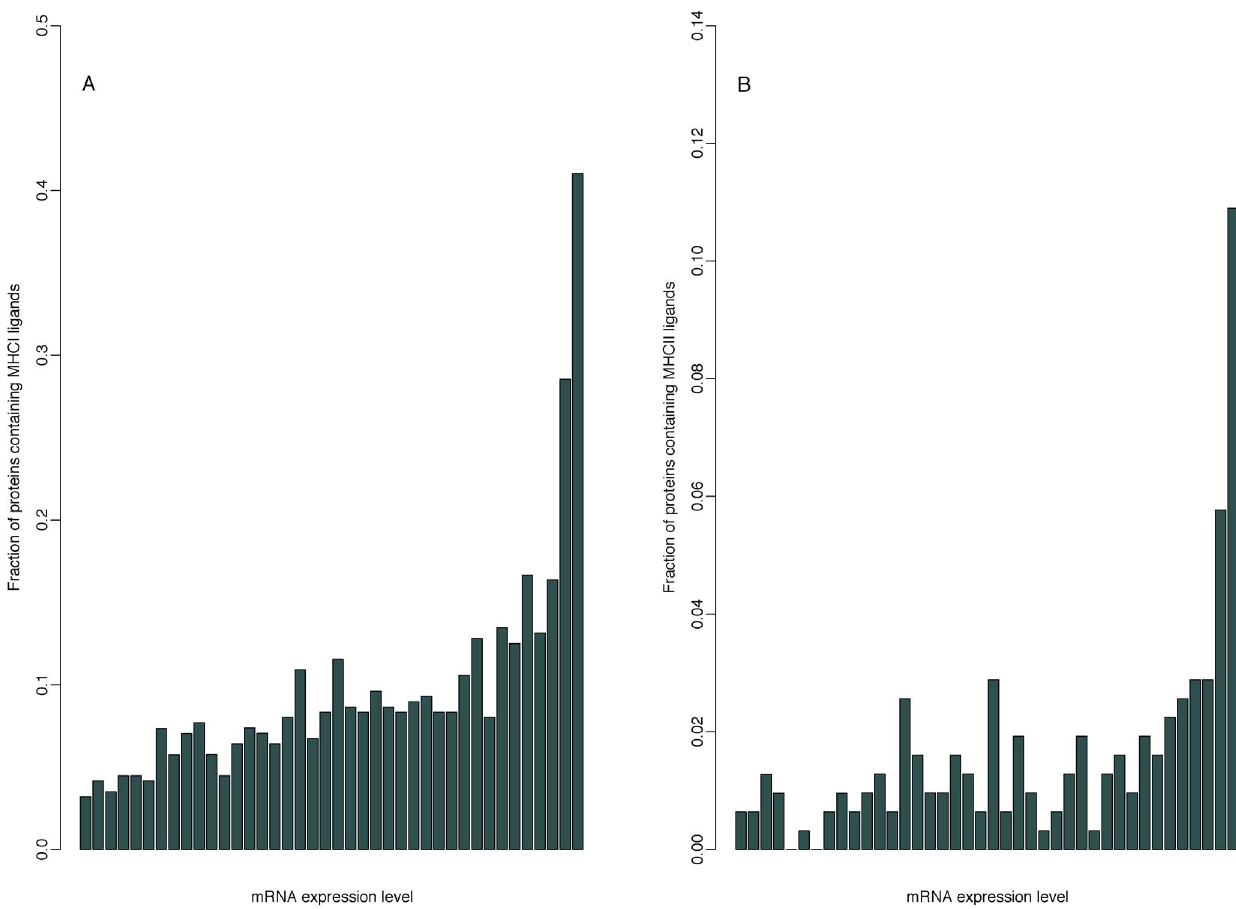
Figure 2. Distribution of MHC ligand-containing proteins relative to their mRNA expression level. The proteins were grouped into bins of equal size, such that each bin contains 2.5% of all proteins in the data set. As a result, each bin comprises an equal number of proteins, increasing in mRNA expression level from left to right. The height of each bar represents the fraction of proteins that contain MHC ligands. A: Fraction of proteins that contain MHC class I ligands versus the mRNA expression level of the proteins according to the GNF gene expression database B: Fraction of proteins that contain MHC class II ligands versus the mRNA expression level of the proteins according to the GNF gene expression database.